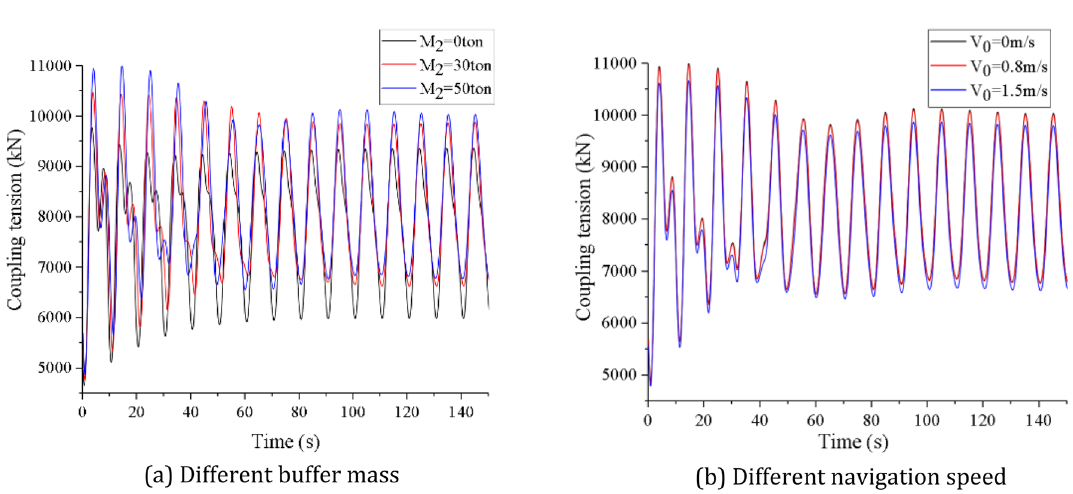
Figure 16. Time domain curve of coupling tension under different buffer mass and different navigation speed (created by Origin 2017 software, URL: https:// www. origi nlab.